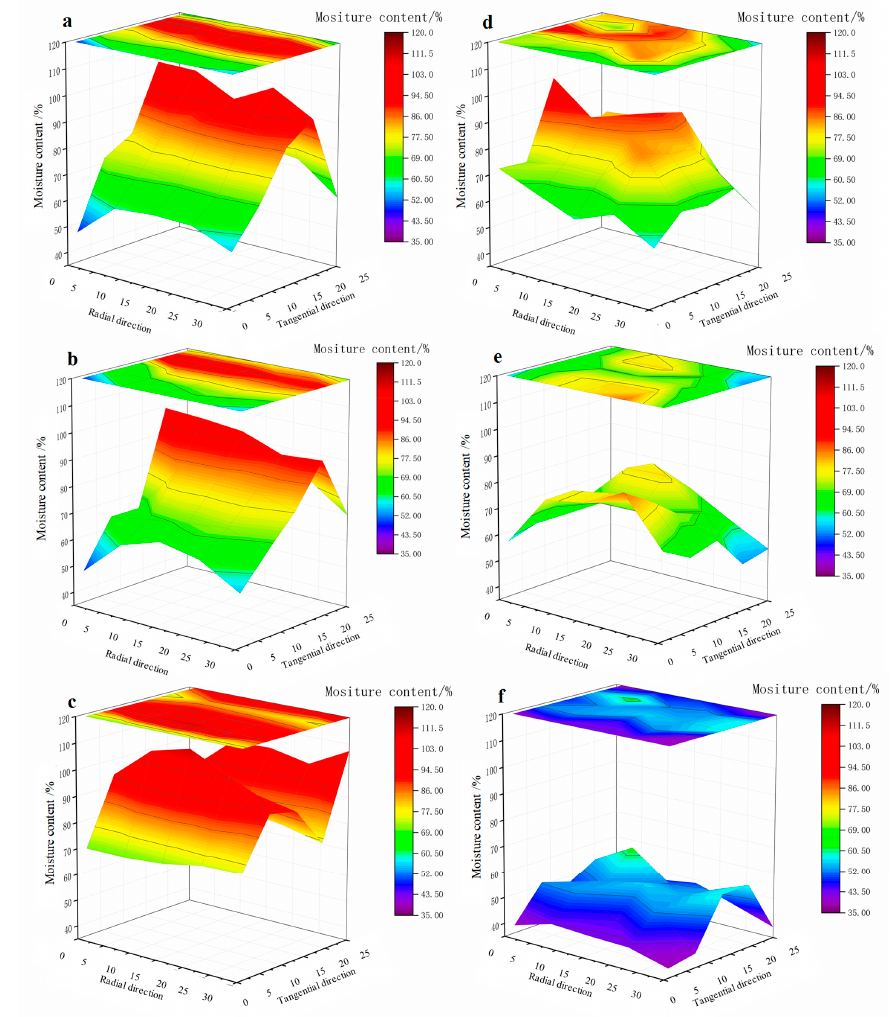
Figure 5. Distributions of wood final MC after 1 h SuCO 2 dewatering. ( a ): 10 MPa/35 °C, ( b ): 10 MPa/40 °C, ( c ): 10 MPa/55 °C; ( d ): 30 MPa/35 °C, ( e ): 30 MPa/40 °C, and ( f ): 30 MPa/55 °C.